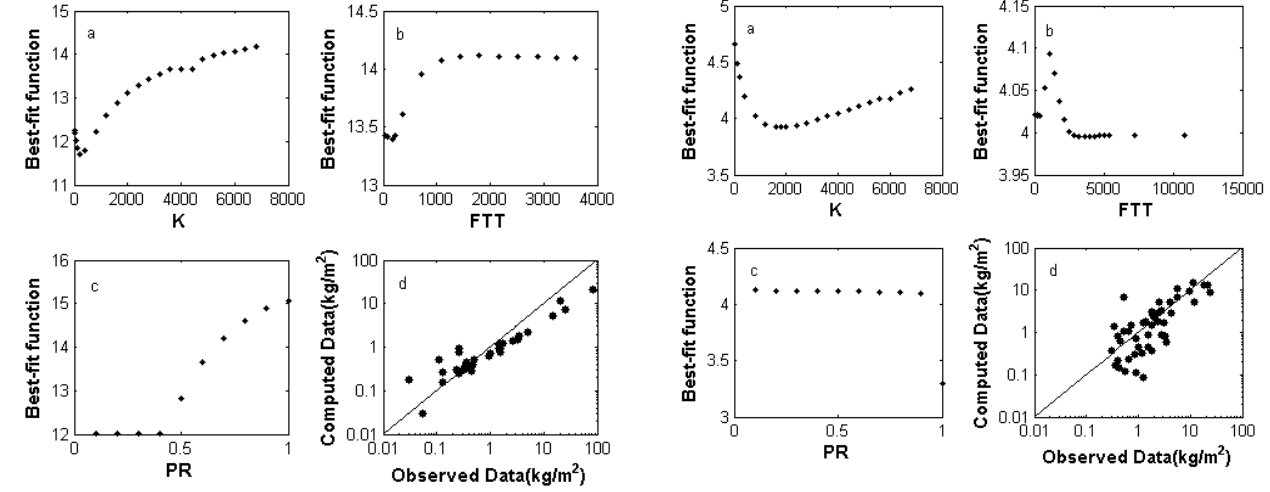
Fig. 2. Misfit function calculated varying: (a) the atmospheric hor- izontal diffusion coefficient ( K ) between 0.001 and 6800 2 s − 1 ; Figure 2. Misfit function calculated varying: a) the atmospheric horizontal diffusion 616 (b) the fall-time threshold (FTT) between 36 and 3600s and (c) the coefficient (K) between 0.001-6800 m 2 s -1 ; b) the Fall Time Threshold (FTT) between 36-617 plume ratio (PR) between 0 and 1; (d) Log plot shows the compar- ison between computed and observed data. Computed data are ob- 3600 sec and c) the Plume Ratio (PR) between 0-1; d) Log plot shows the comparison 618 tained by introducing the following best-fit values into the model: between computed and observed data. Computed data are obtained by introducing the 619 K = 200m 2 s − 1 , FTT = 180s, and PR = 0.4. following best fit values into the model: K = 200 m 2 s -1 , FTT= 180 s, and PR=0.4. 620 621